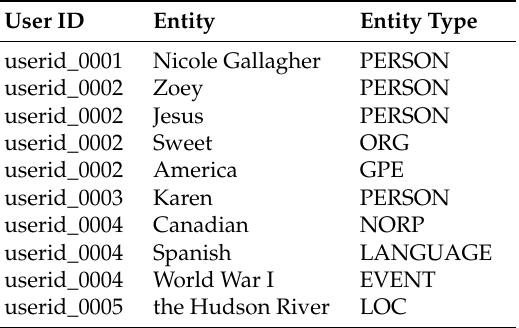
Table 3. Extracted entities from FB